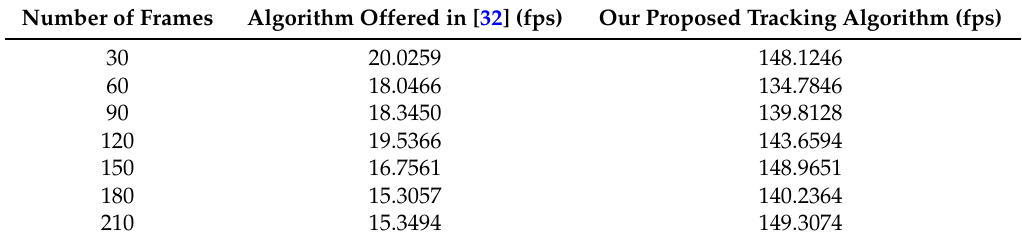
Table 2. Comparison of the algorithms.